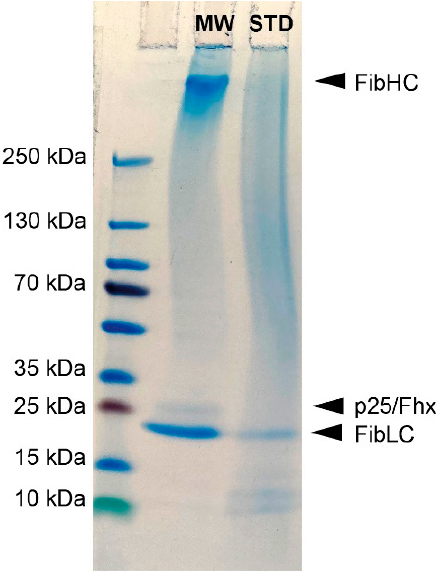
Figure 2. SDS-PAGE analysis of degummed silk fibers prepared by standard degumming (STD) or by microwave degumming (MW). Degummed fibers were dissolved in LiSCN and 40 µg of each silk fibroin solution was loaded on a precast gradient polyacrylamide gel (4–20%). PageRuler™ Plus Prestained Ladder (10 to 250 kDa) was used as a molecular mass marker. The molecular mass of the three subunits of silk fibroin (heavy chain fibroin, FibHC, 350 kDa; light chain fibroin, FibLC, 26 kDa; fibrohexamerin/p25, 30 kDa) are indicated by arrowheads.